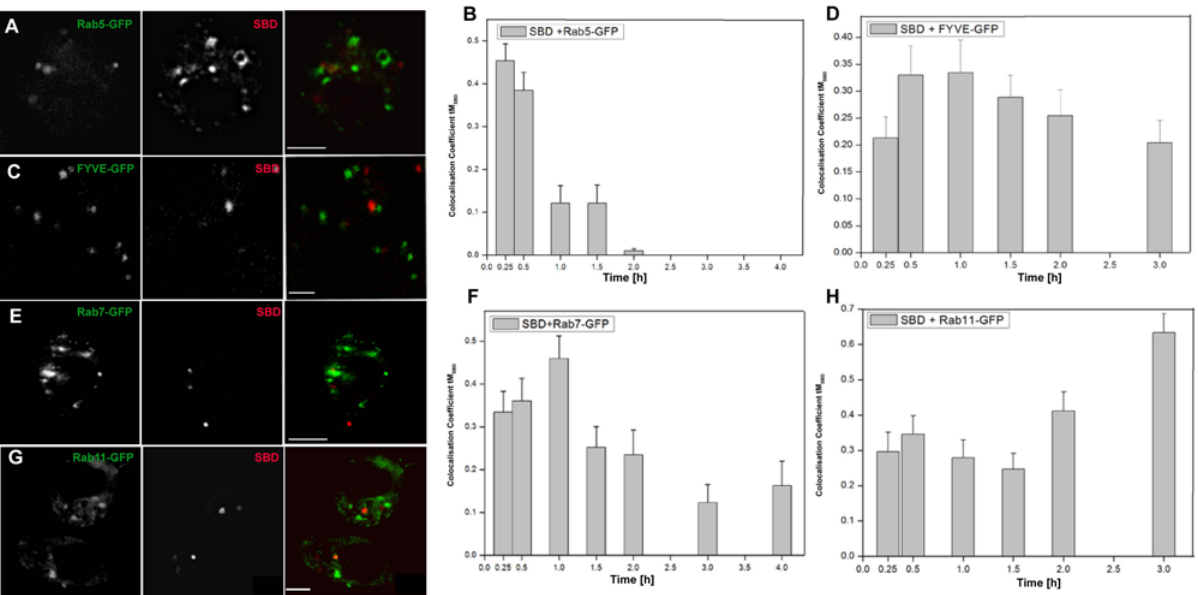
Figure 6. Pulsed SBD-TMR traffics sequentially via rab5-, rab7-, and FYVE-positive vesicles to rab11 recycling endosomes in c6 cells. A, B. SBD colocalizes maximally with rab5-GFP positive early endosomes between 15 and 30 min. Cells were imaged 30 min after application of SBD. C, D. SBD colocalizes maximally with FYVE-GFP positive sorting and multivesicular endosomes between 30 min and 2 h. E, F. SBD colocalization with rab7-GFP positive late endosomes peaks at 1 h. G, H. SBD colocalizes strongly with rab11-GFP positive recycling endosomes only later, at 3 h. For all labellings, SBD-TMR (10 m M in growth medium) was incubated at 25 u C for 10 min on cells that had been transfected with the indicated constructs 24–40 h earlier. Cells were imaged at 60 min after application of SBD-TMR in C, E, and